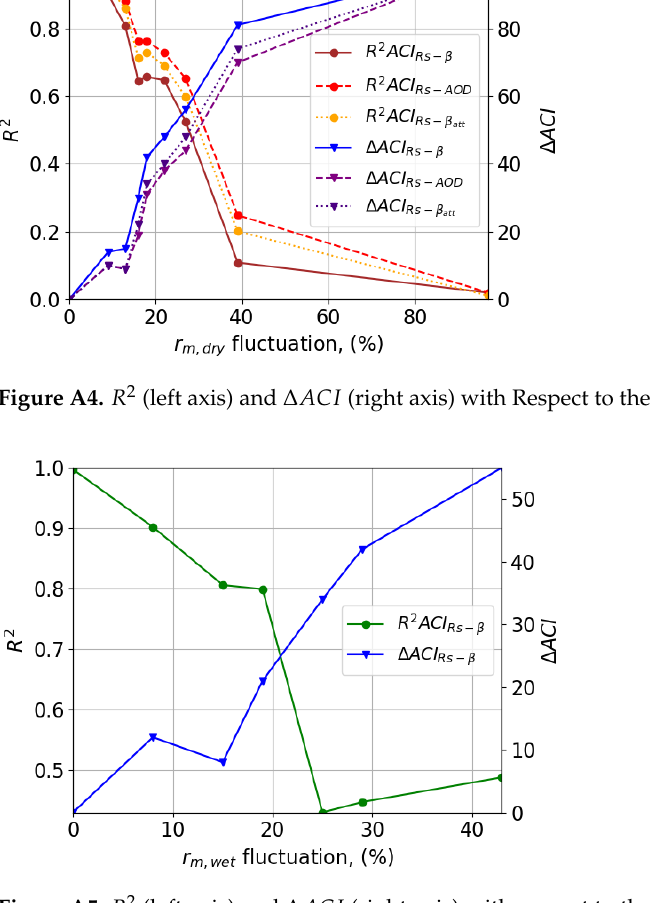
− β and ∆ ACIref f − β because the uncertainty d